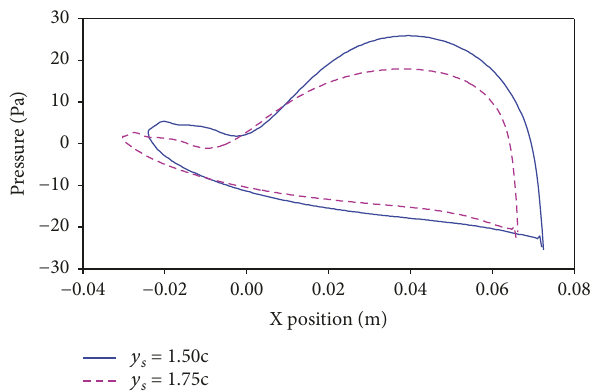
Figure 13: The pressure of the up and down surfaces of the counter- fl apping up wing with y = 1 50 c and 1 75 c at t = 5 50 T s